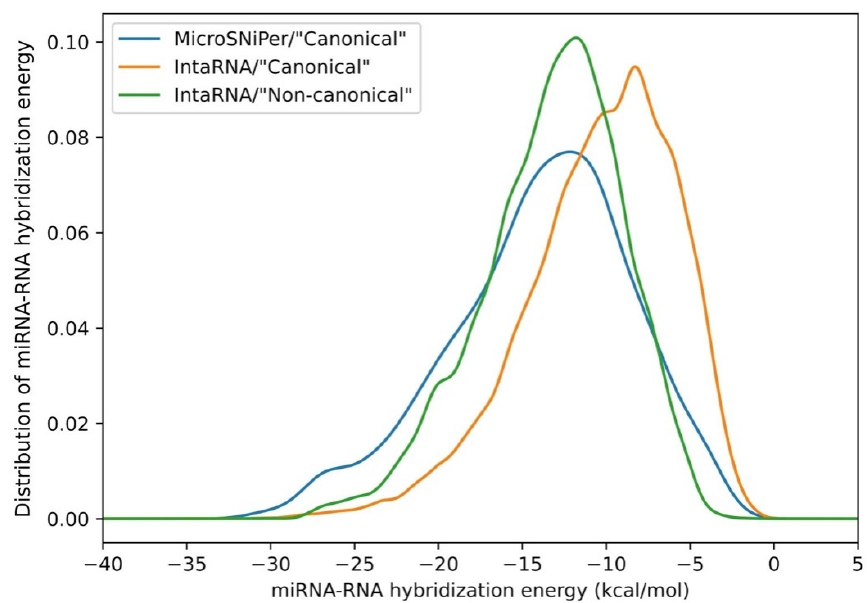
Figure 2. The distribution of miRNA-RNA hybridization energy values for all predicted interactions between miRNA and DROSHA 3 ′ -UTR with and without SNPs. MicroSNiPer finds mostly strong canonical seeds compared to IntaRNA. The difference between “canonical” and “non-canonical” interaction energies calculated by IntaRNA is probably due to the higher demand of “non-canonical” seeds for internucleotide bonds.